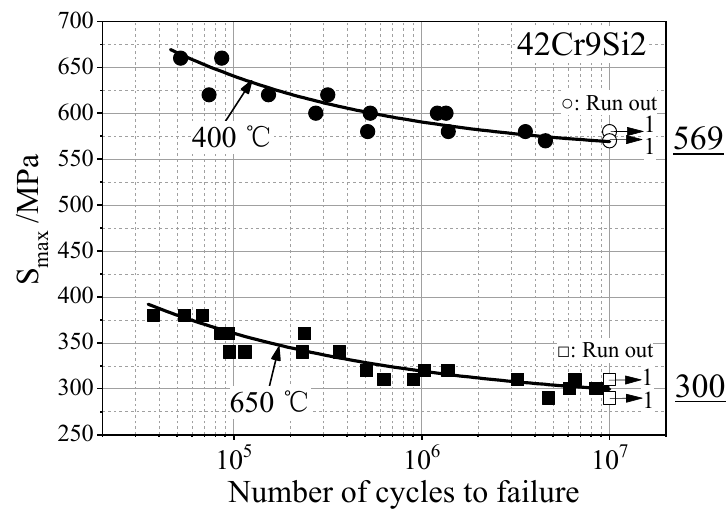
Figure 11. S-N curves of the 42Cr9Si2 steel at the temperatures of 400 °C and 650 °C.